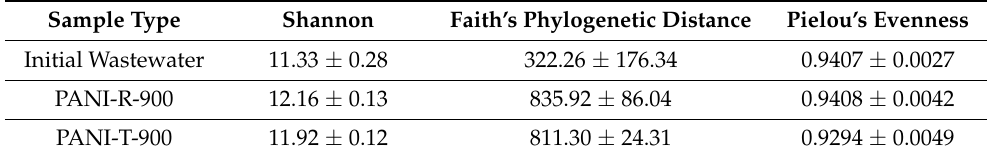
Table 3. Alpha diversity across sample types. Shannon entropy, Pielou’s evenness, and Faith’s phylogenetic distance were calculated using qiime2 core metrics